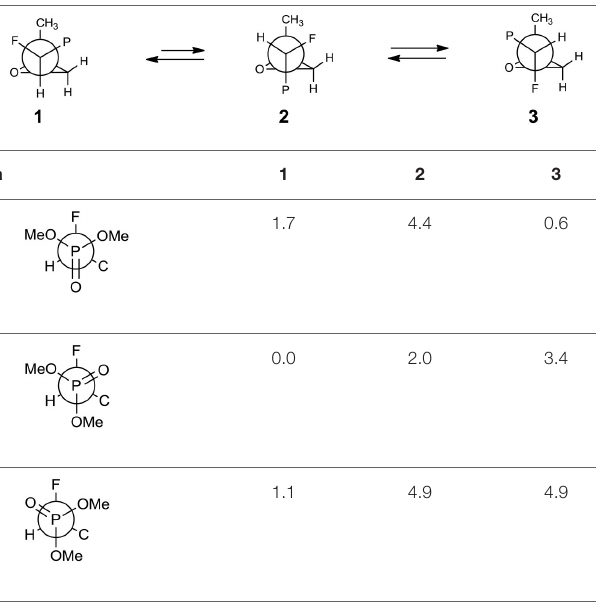
TABLE 2 | The geometries and relative energies [kcal/mol] of nine energy minima for the compound 5a .